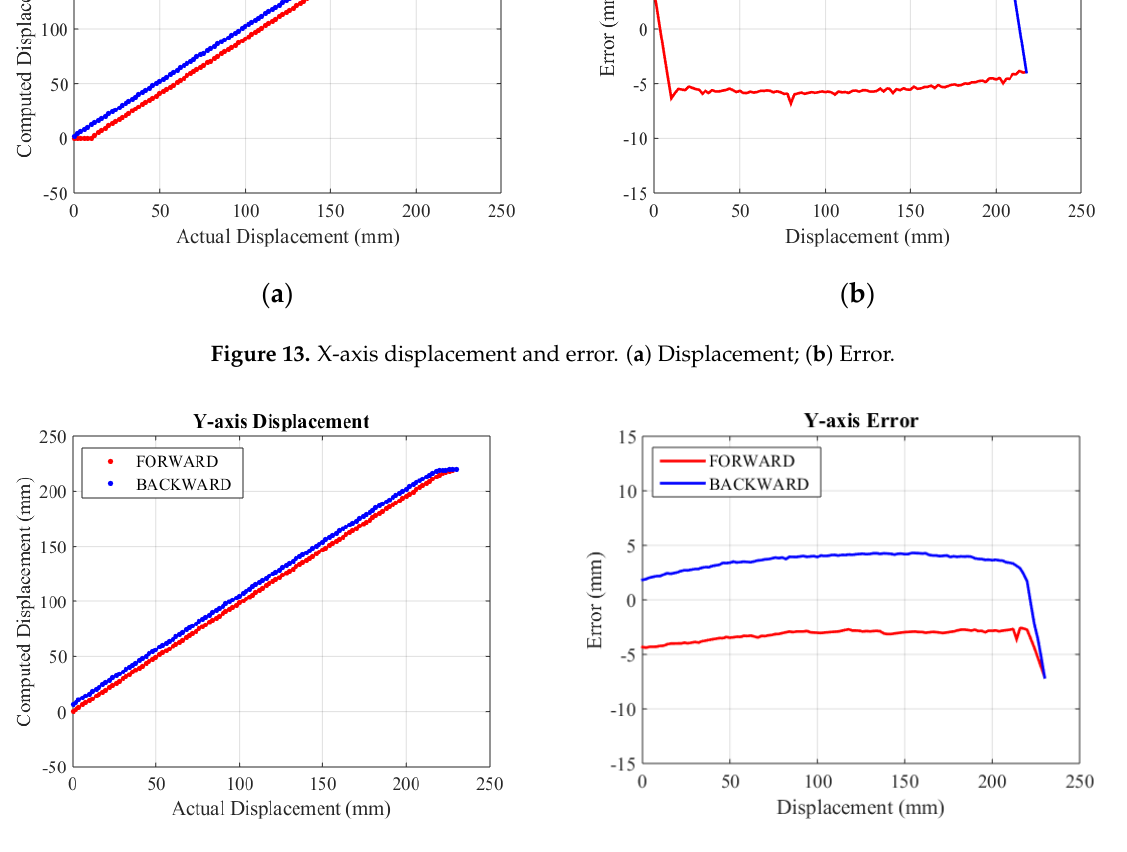
( b ) Figure 15. Z-axis displacement and error. ( a ) Displacement ; ( b ) Error. For the convenience of analysis, we defined computed error as the difference between mechanical error and displacement error. Displacement error mainly comes from mechanical error and computed error. The mechanical error stems from small backlashes (mainly gear clearance) in the structure. Linking bars magnify these backlashes and make errors relatively large. From the initial error figures above, it can be seen that the mechanical error of the X-axis is about 10 mm, while